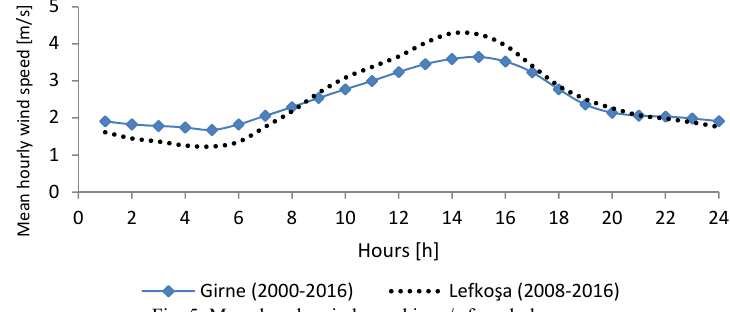
Fig. 5: Mean hourly wind speed in m/s for whole years